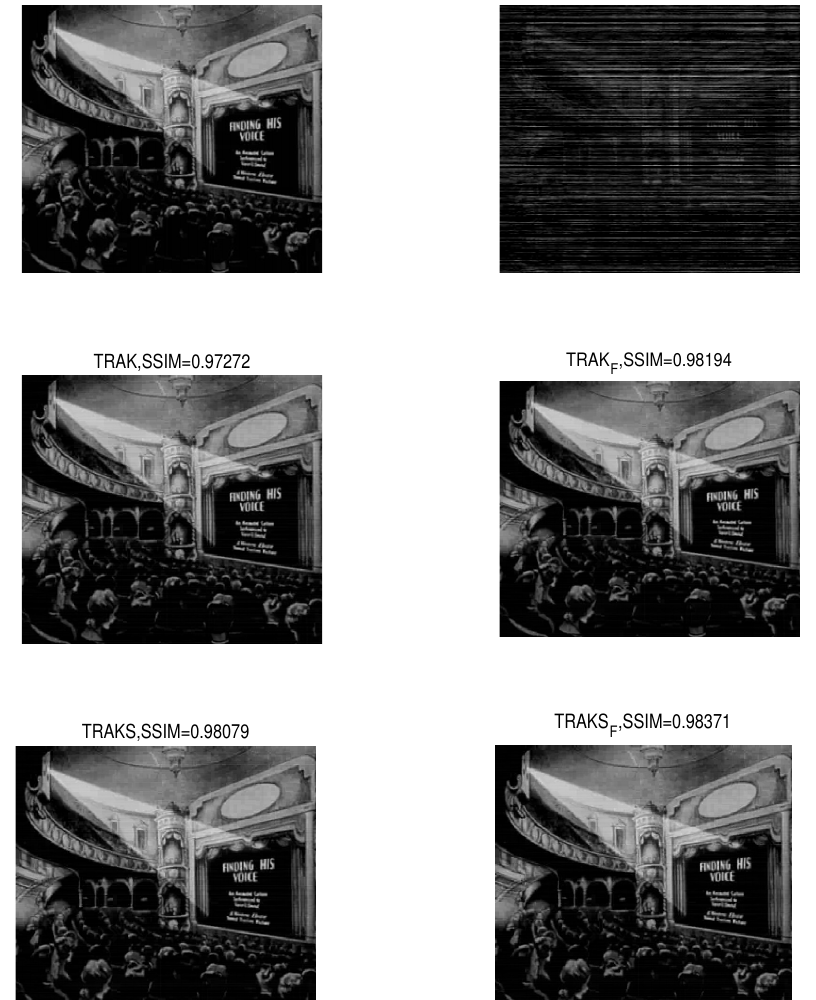
Figure 8. The 50 th frame of the clean film and the images recovered by the TRK, TRAK, TRAK F , TRAKS, and TRAKS F algorithms. CPU TRK = 6.6113, CPU TRAK = 6.1381, CPU TRAK = CPU TRAKS = 6.0760, CPU TRAKS F